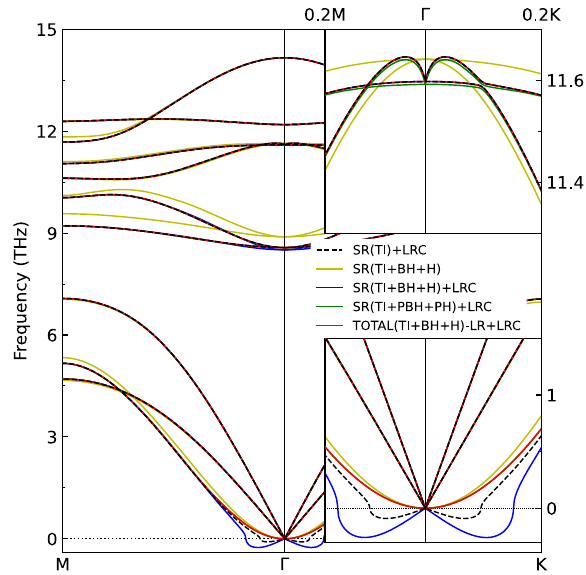
Fig. 4 Comparison between the phonon dispersions of an infrared-active 2D MoS 2 with the corrections of Born-Huang (BH) rotational invariance and Huang (H) conditions on the short- range (SR) IFCs and on the total IFCs. The polar Born-Huang (PBH) rotational invariance and polar Huang (PH) conditions are also considered. The TI denotes the correction of translational invariance. When correcting the total IFCs, the contributions from the long- range (LR) IFCs are further removed in real space and an analytic long-range correction (LRC) is then added back in reciprocal space to recover the LO-TO splitting. The inset show zoom-in results around the Γ point and the LO-TO splitting at the E 0